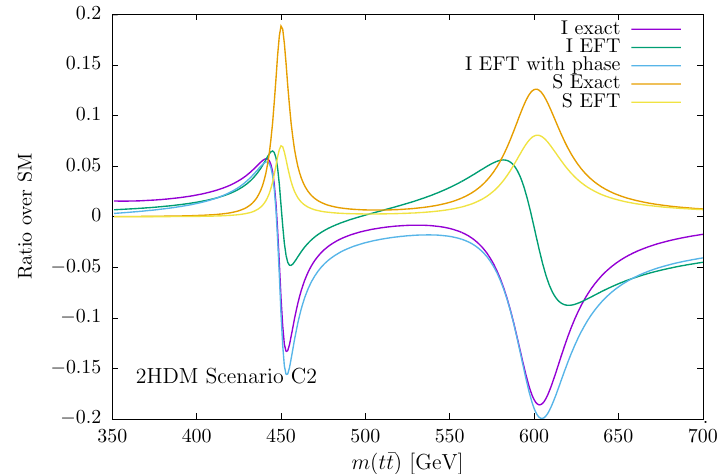
Figure 10 . Signal and interference over background ratios, computed from EFT (with and without the additional phase) and from the exact one-loop